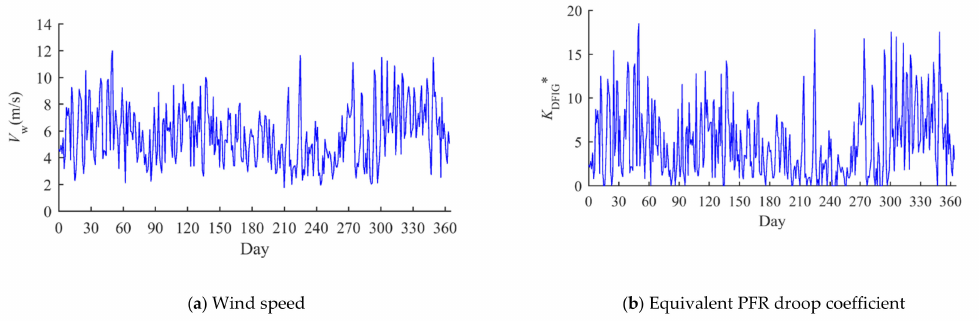
Figure 14. Wind speed and the K DFIG * of a city for a year, the wind speeds data is taken from NASA [26].